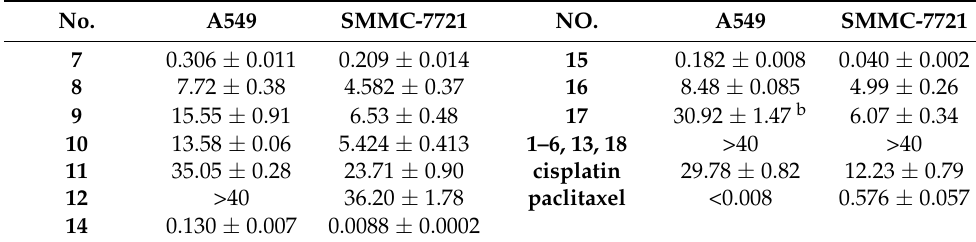
Table 3. Cytotoxicities of compounds 1 – 18 against A549 and SMMC-7721 cell lines (IC 50 , µ M) a .